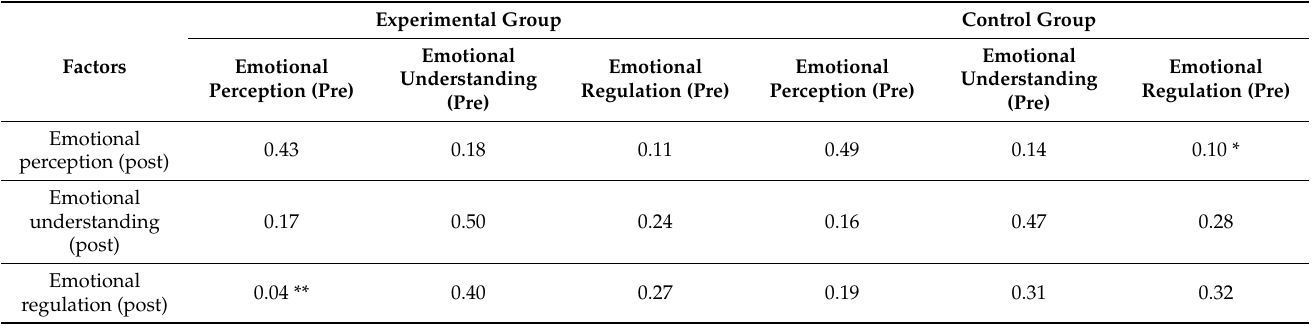
Table 2. Correlation matrix between the factors that make up emotional intelligence in the